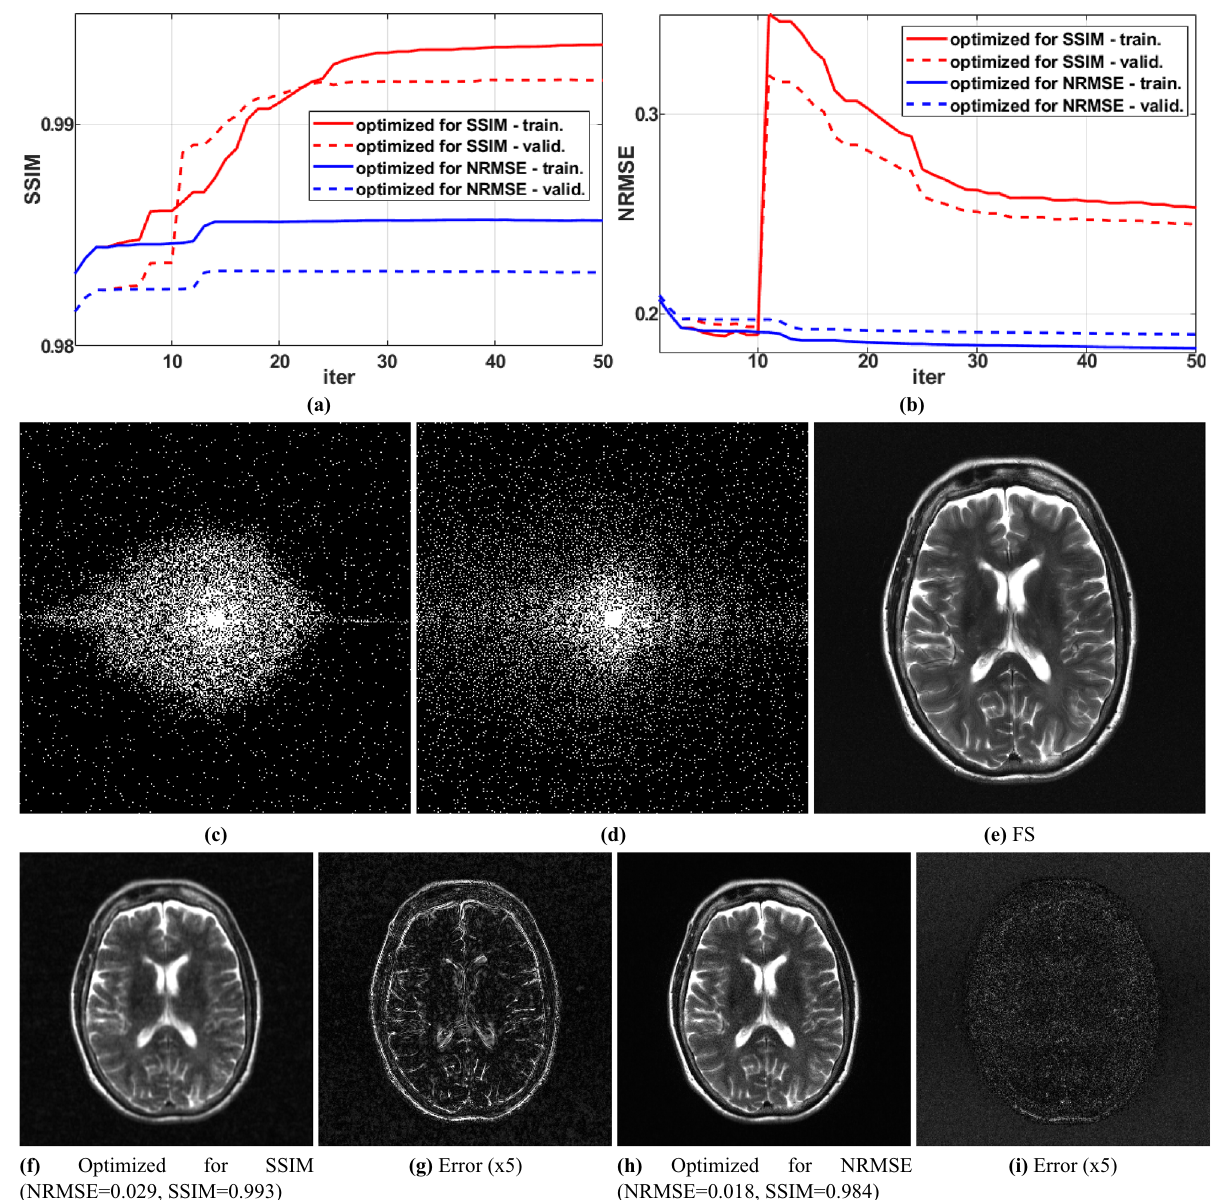
Figure 9. Comparing BASS in optimizing SSIM (higher is better) and NRMSE (lower is better). ( a ) SSIM and ( b ) NRMSE along the iterations, ( c ) SP obtained by optimizing SSIM, ( d ) SP obtained by optimizing NRMSE, and some visual results with fully sampled reconstruction in ( e ), example of images with SP obtained by optimizing SSIM in ( f ) and NRMSE in ( h ), and their error maps ( g ) and ( i